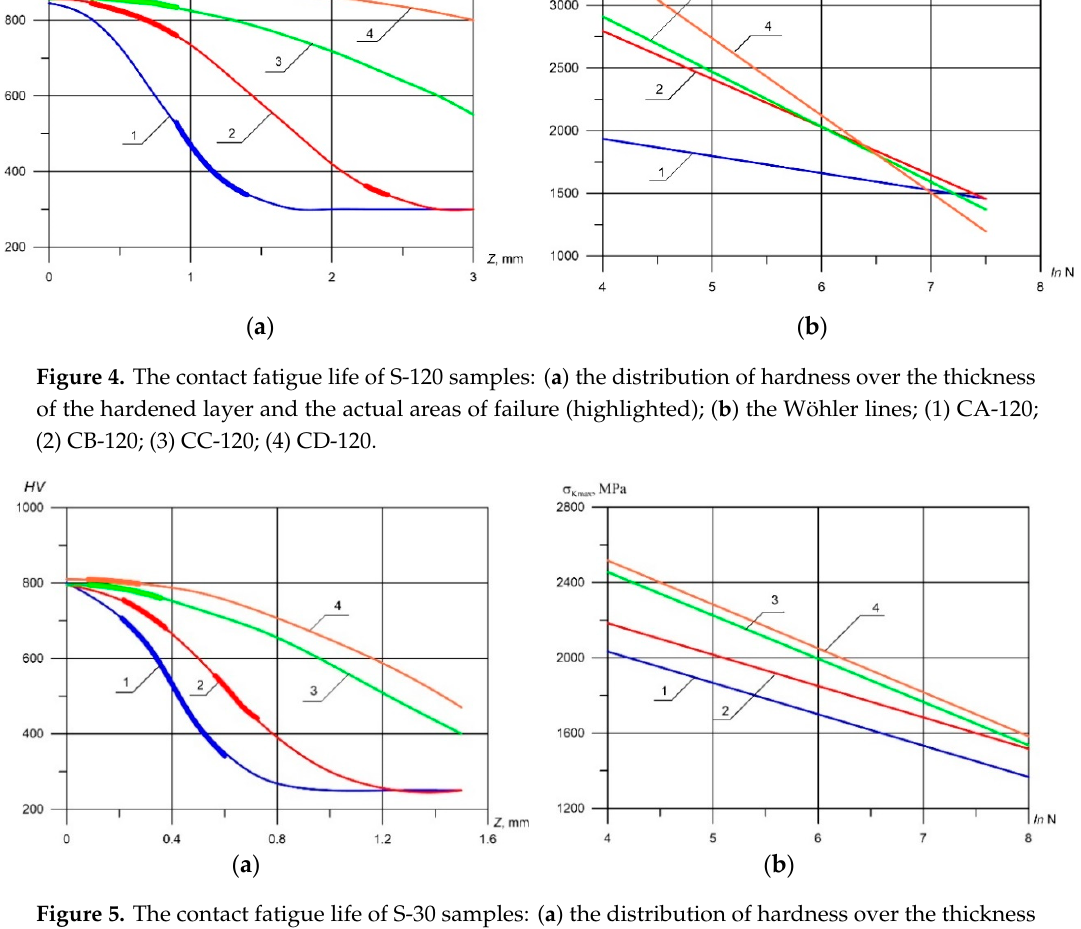
Figure 5. The contact fatigue life of S-30 samples: ( a ) the distribution of hardness over the thickness of the hardened layer and the actual areas of failure (highlighted); ( b ) the Wöhler lines; (1) CA-30; (2) CB-30; (3) CC-30; (4) CD-30. C-120 Rollers D = 120 mm. The lower boundary of the z p of samples CA-120 destruction was at depths (1.4–1.7) b H with hardness H = 300–320 HV; for samples C-120 and CD-120, at depths (0.45–0.85) b H at H > 900 HV for CD-120 and H > 830 HV for CC-120. DCS regions took place